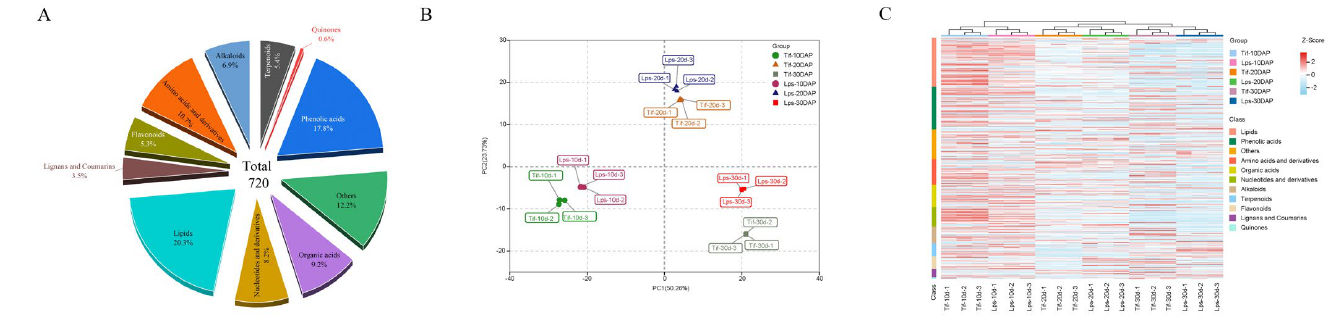
Figure 2. Metabolomic data analysis in peanut pod. ( A ) Functional classification of all detected metabolites. ( B ) Principal component analysis (PCA) of metabolites. ( C ) Clustering heatmap of the metabolites during pod